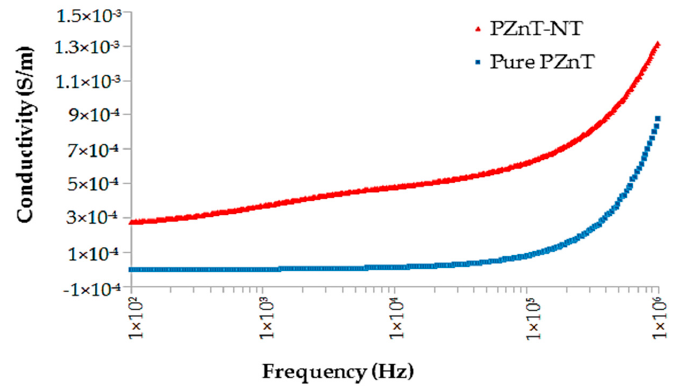
Figure 6. Conductivity of the PZnT-NT and the pure PbZn 0.3 Ti 0.7 O 3 at room temperature.